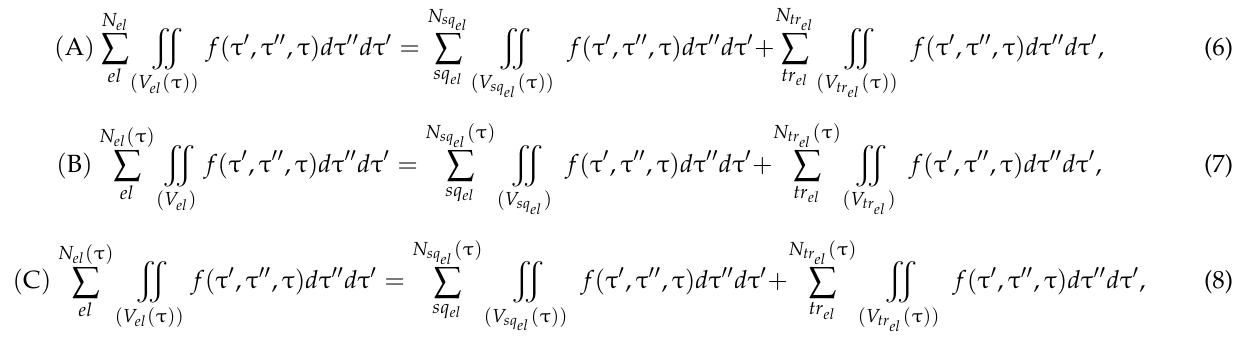
N and N are the tr is the triangular element, el el tr el sq V and V are the volumes of square el sq el tr